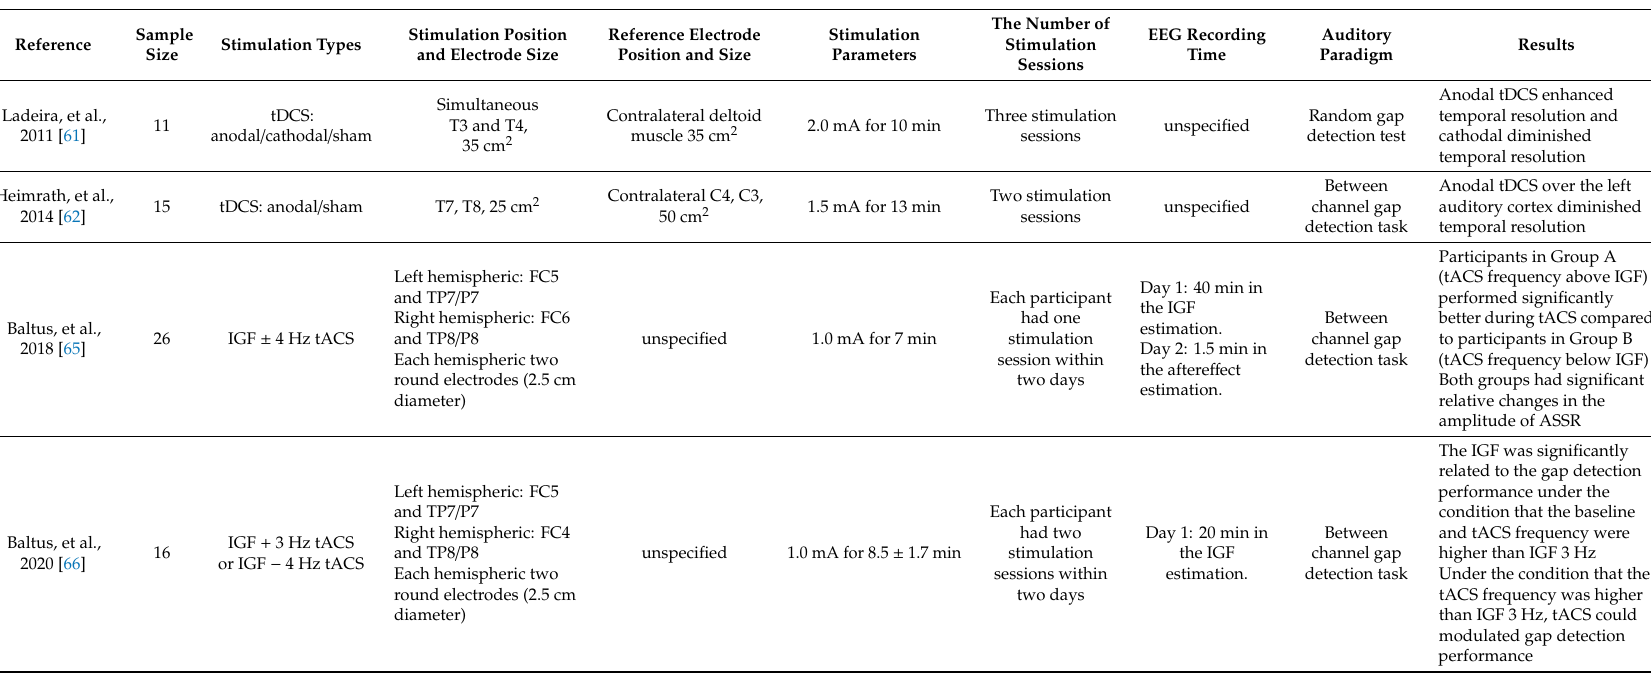
Table 2. Partial parameters and results of auditory process